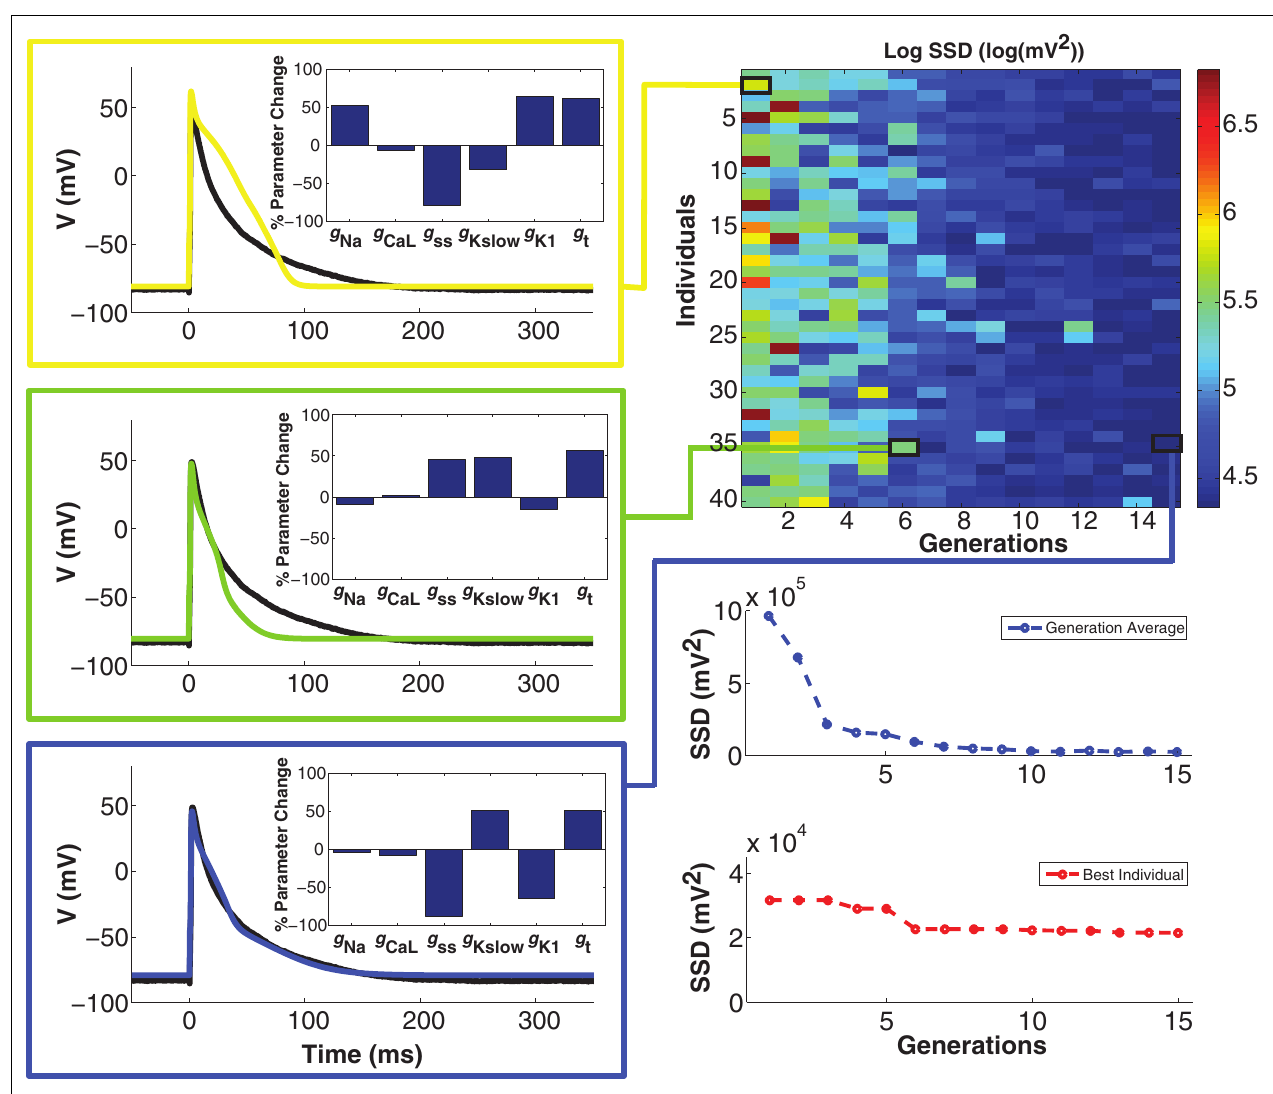
(color-coded as per error heat map) with GA progression. In the first generation (yellow), there is a substantial difference between the phenotype and the optimization objective (black trace). In the sixth generation (green), a very different genotype gives a better fit. In the 15th and final generation (blue), another genotype gives a very strong fit. Bottom right panels: convergence of the average error for the population ensemble (blue) as well as the error of the best individual (red) occurs within a few